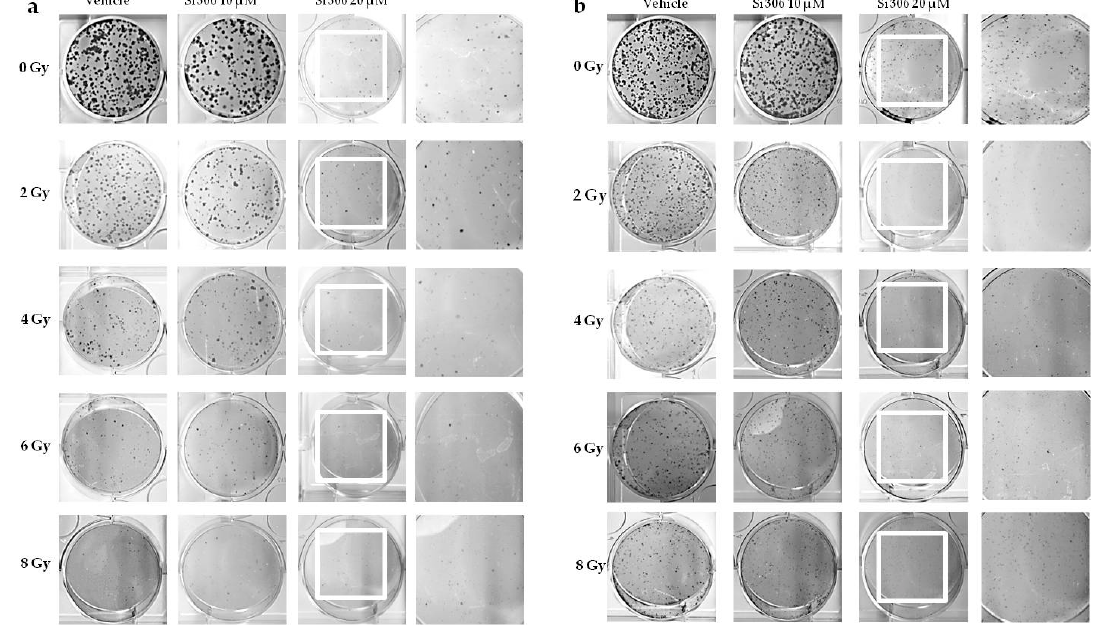
Figure 1. U251 clones after X-ray irradiation combined with Si306 in normoxia (21% oxygen) ( a ) and hypoxia (1% oxygen) ( b ).